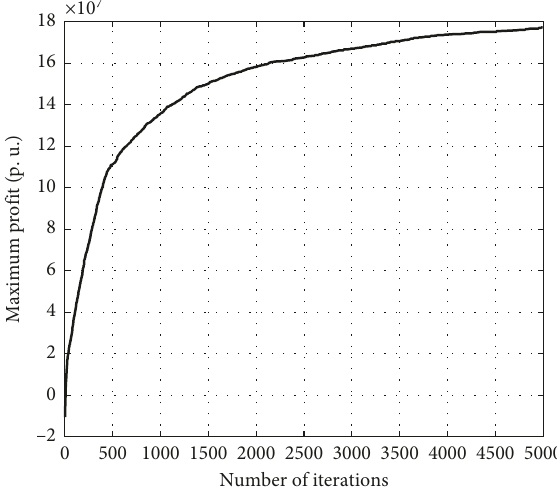
Figure 13: Profit of the community for 5000 iterations (termi- nation condition).